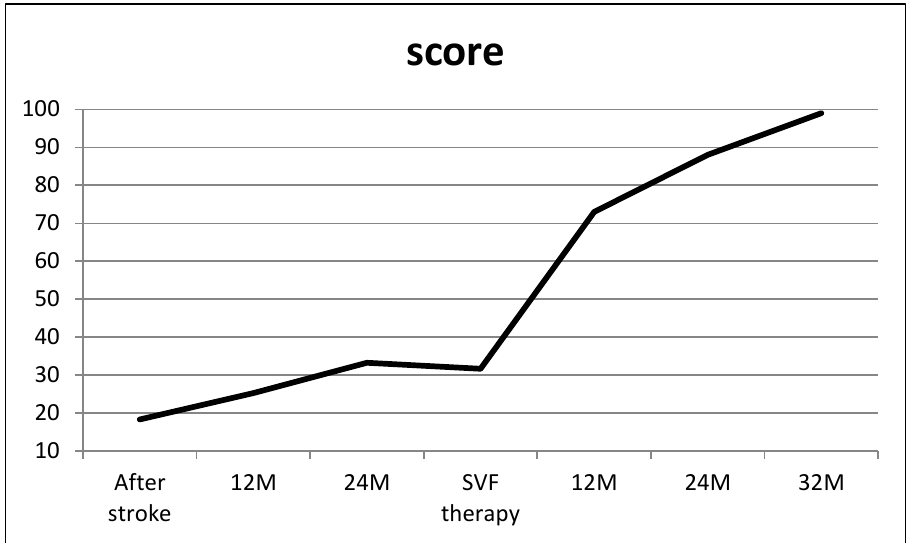
Figure 1. A total score analyzed by modified Stroke Specific Quality of Life Scale. The score was evaluated in the range from 1 to 100, where 100 reflect the patient’s complete health.